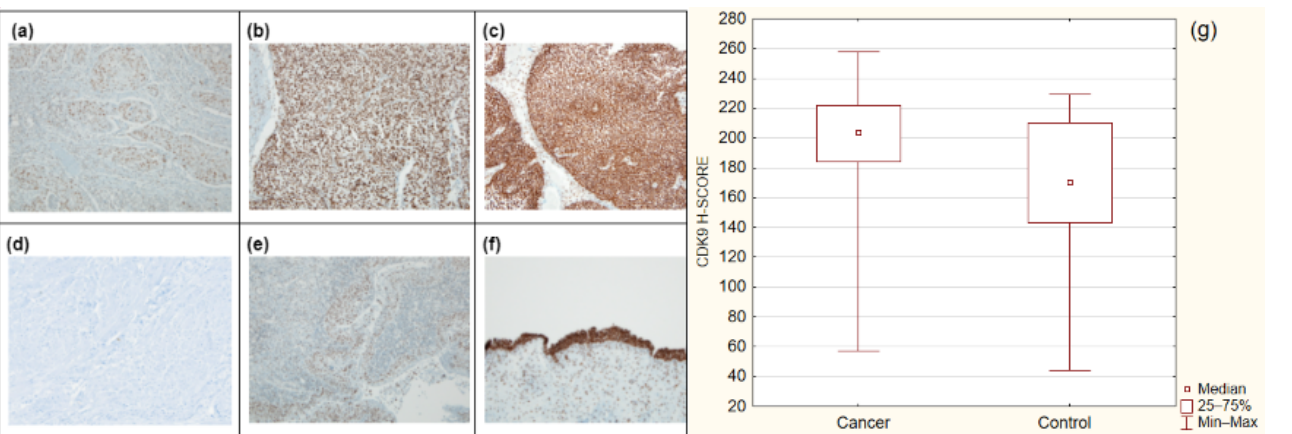
Figure 1. Representative cross-sectional staining patterns at x10 magnitude; ( a ) invasive bladder cancer with low CDK9 expression; ( b ) non-invasive bladder carcinoma with medium CDK9 expression; ( c ) non-invasive bladder cancer with high CDK9 expression; ( d ) CDK9 negative control; ( e ) normal mucosa with low CDK9 expression; ( f ) normal mucosa with high CDK9 expression and positive reaction in the cells of the stromal inflammatory infiltration; ( g ) CDK9 expression in cancer and control groups ( p = 0.0022).